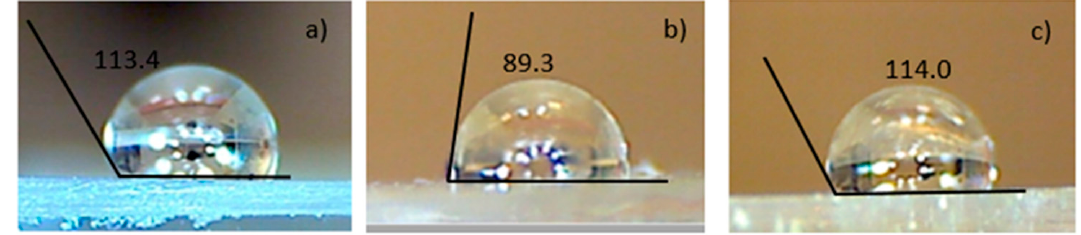
Figure 9. Wettability measurement for PDMS virgin ( a ), PDMS with HOPG deposited by PLD ( b ), PDMS with HOPG deposited by LIBT ( c ).